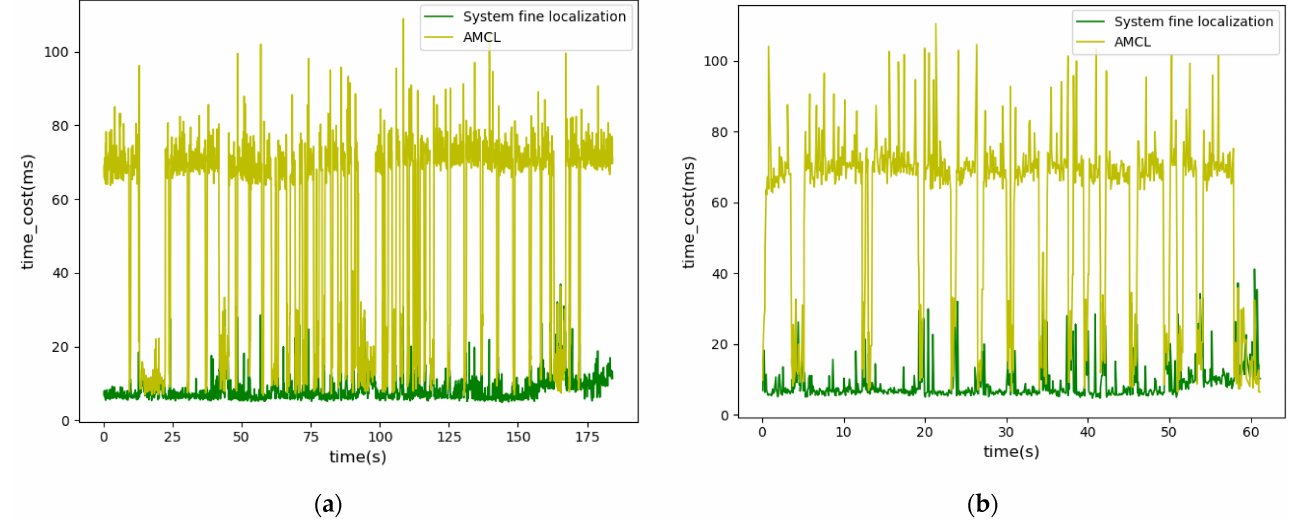
Figure 22. Comparison of the calculation time of the two test trajectories ( a ) trajectory 1 ( b ) trajectory